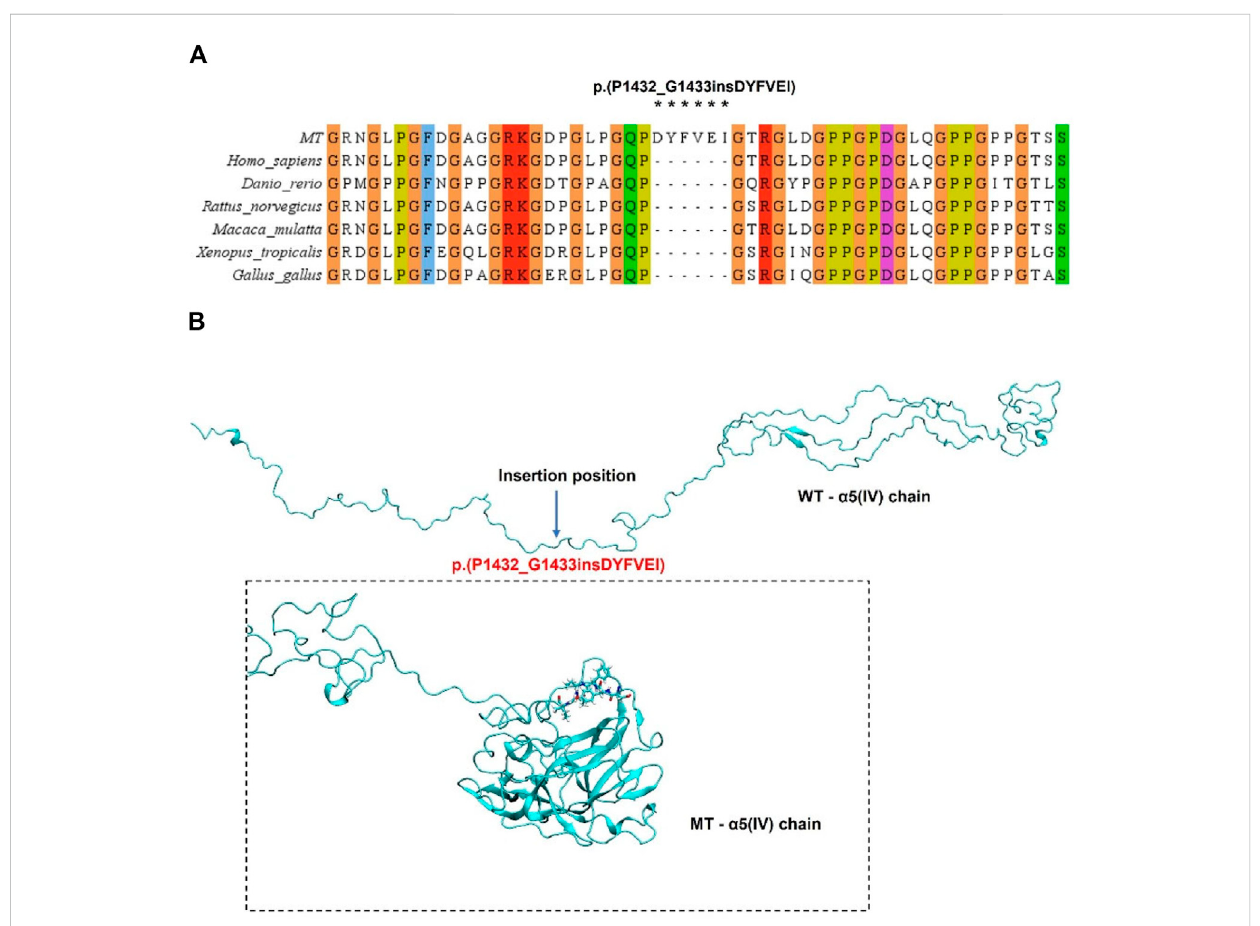
FIGURE 4 Analysis of COL4A5 mutations. (A) Evolutionary conservation of amino acid residues altered by p.(P1432_G1433insDYFVEI) across different species. NCBI accession numbers are Homo sapiens : NP_000486.1; Danio rerio : NP_001116702.1; Macaca mulatta : XP_014983488.2; Xenopus tropicalis : XP_ 004916922.2; Gallus gallus : XP_015134092.2. Asterisk (*) means Inserted amino acids. (B) Through homology modeling analysis, the blue label is the magni fi cation to con fi rm the Inserted amino acids at positions 1,432 –